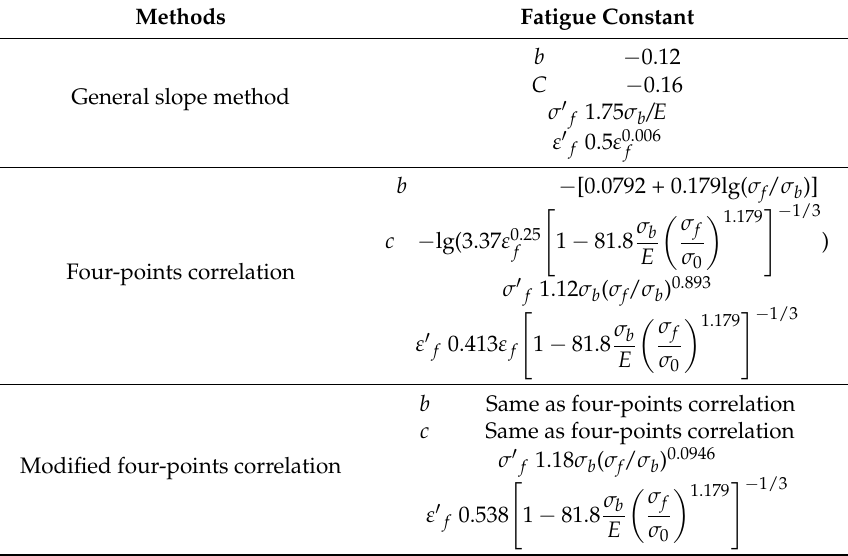
Table 6. Estimation method for fatigue